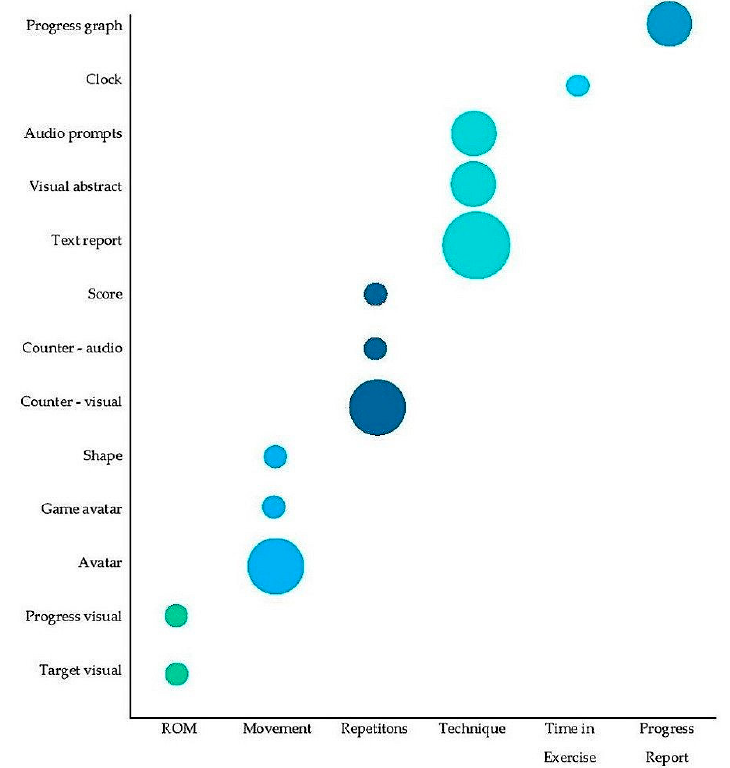
Figure 3. Feedback features used to represent exercise components. The size of the circle corresponds to frequency that each feedback feature was used to represent the exercise component.